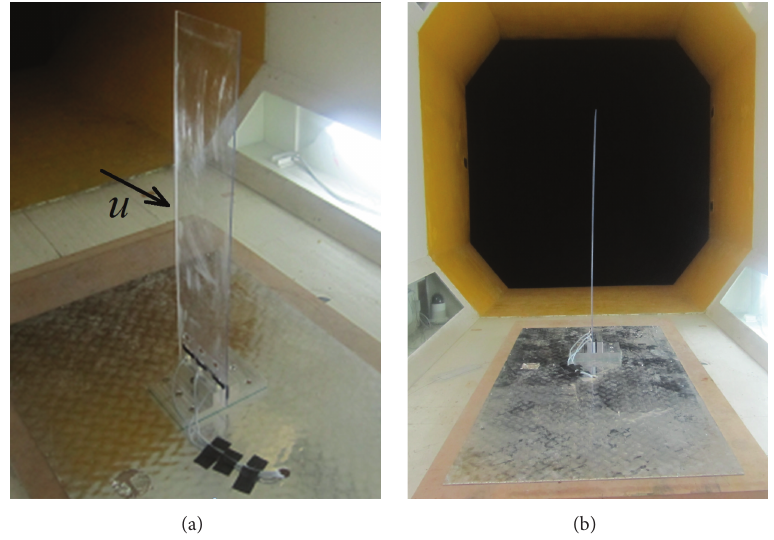
Figure 2: Experimental setup for PC plate structure: (a) side view and (b) front view.